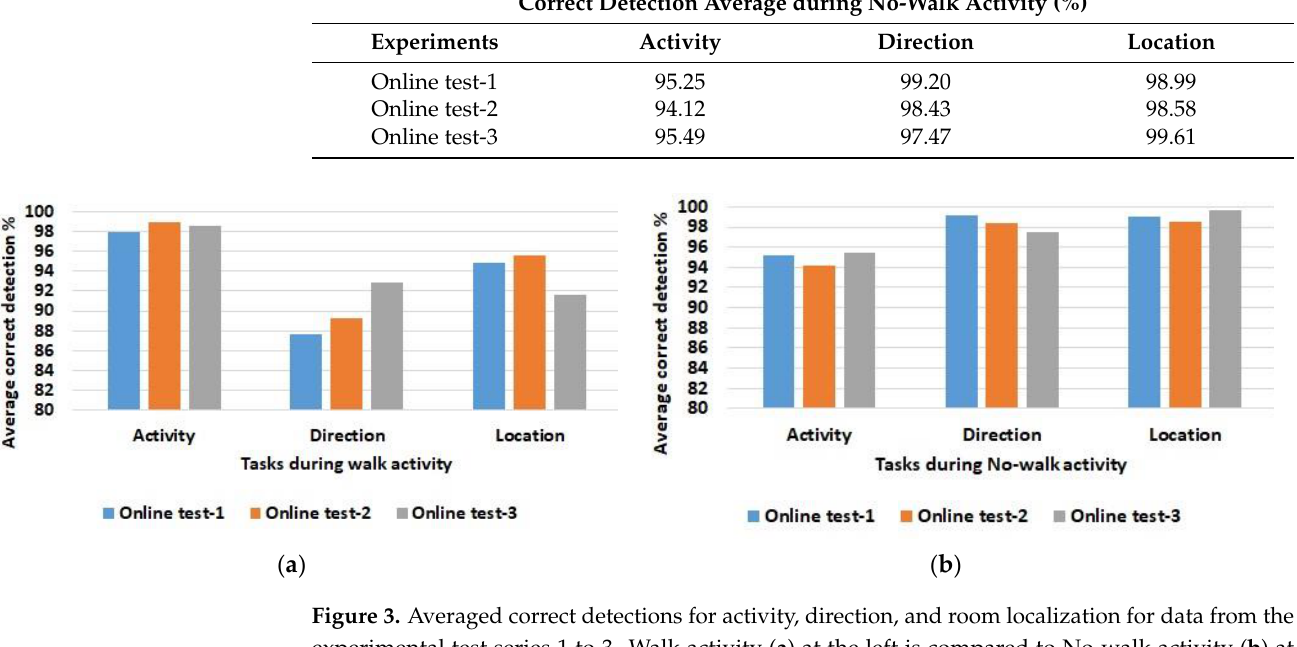
Figure 3. Averaged correct detections for activity, direction, and room localization for data from the experimental test series 1 to 3. Walk activity ( a ) at the left is compared to No-walk activity ( b ) at the right. Note that the y -axis ranges from 80 – 100% for better resolution of the differences between the results.